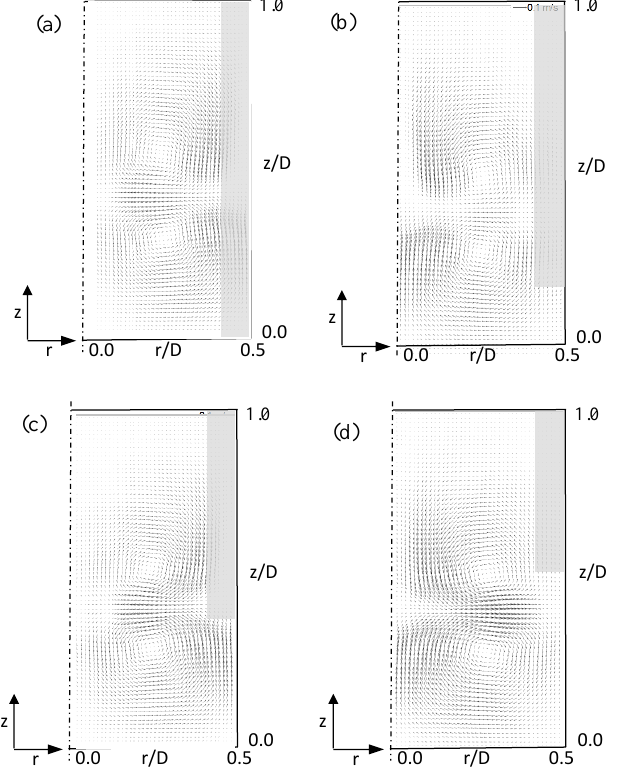
Fig. 6. Velocity field for h/H =1/3 Rushton turbine for rotational speed N =200 rpm and lenght of baffles (a) L=H, (b) L=3/4H, (c) L=2/3H, (d) L=1/2H